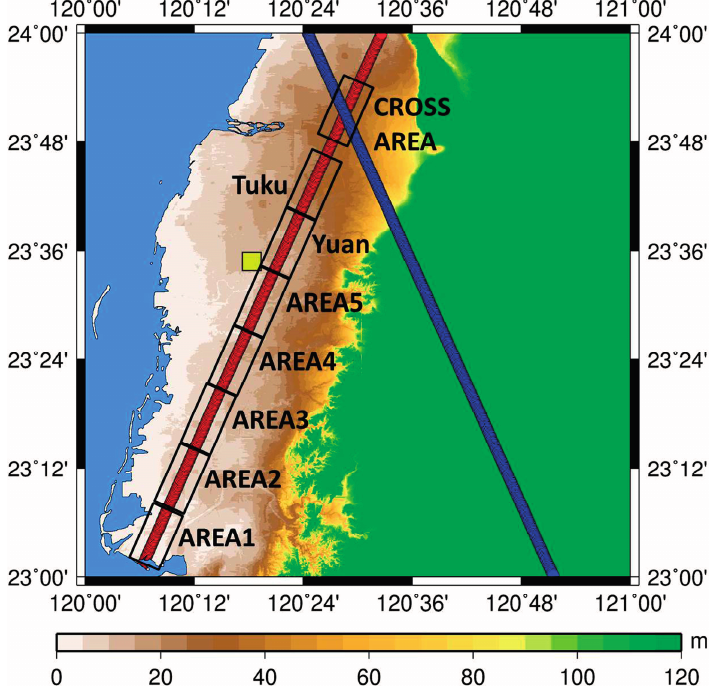
Figure 1. Study regions. The red and blue lines are T/P (and J-2) pass 51 and pass 164 ground tracks, respectively (scattered footprints rather than continuous lines). The black boxes are the partitions of the study area. The yellow square is the location of GNNS and water vapor radiometer (WVR) instruments. The background is the land altitude derived from DEM [30] and the heights higher than 120 m are all represented as the color as the height of 120